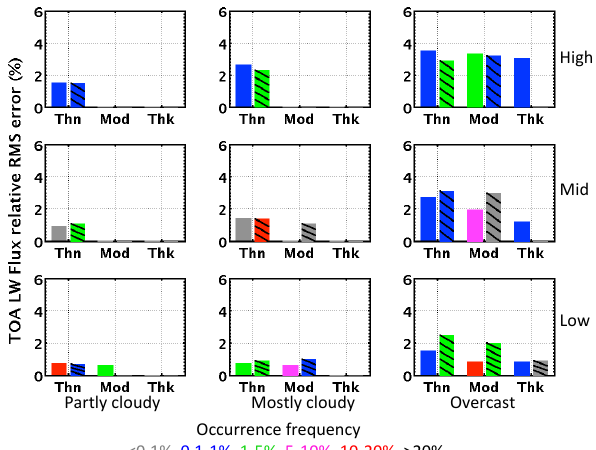
Figure 12. TOA nighttime LW flux consistency (%) between nadir- and oblique-viewing angles for different cloud types over ocean. The left bars are for single-layer clouds, and the right bars (hatched) are for multiple-layer clouds. The color of the bar indicates the oc- currence frequency for each cloud